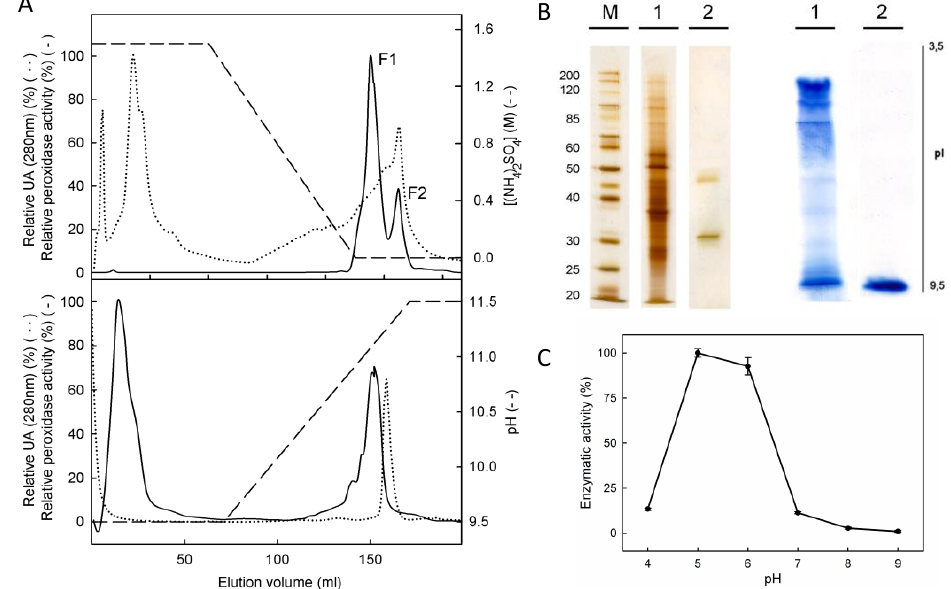
Figure 2. Purified PpaPrx19 is a strongly basic peroxidase. ( A ) Purification process of PpaPrx19, including adsorption chromatography on phenyl Sepharose (upper panel, peak F2) and cationic exchange chromatography on SP Sepharose (lower panel). Profiles of peroxidase activity and protein are denoted either by a continuous or by a dotted line, respectively. ( B ) Protein fingerprint in SDS-PAGE (left) and peroxidase isoenzyme pattern in IEF (right) of the crude extract (1) and the purified peroxidase (2) SDS-PAGE and IEF were revealed using the silver staining method and 4-MN in the presence of H 2 O 2 , respectively. ( C ) Dependence on pH of the purified PpaPrx19 activity. Data presented are average values ± SD of n = 3 experiments. Table 1. Purification of basic peroxidase PpaPrx19 from P. patens . Peroxidase activity was measured using TMB as